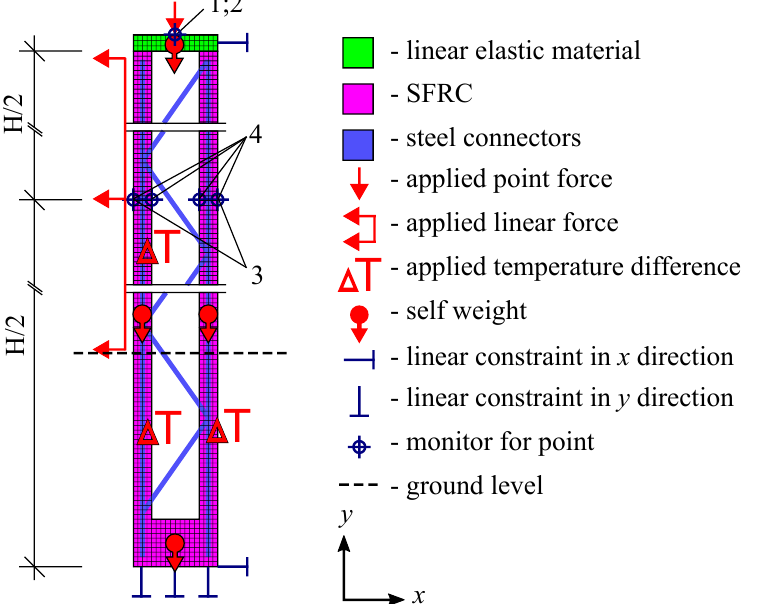
Figure 6. Finite element model used in nonlinear structural analysis: 1 and 2—monitoring points for vertical displacement and force reaction; 3—monitoring points for lateral displacements; 4—stresses and strains in y direction; H—total height of the wall.